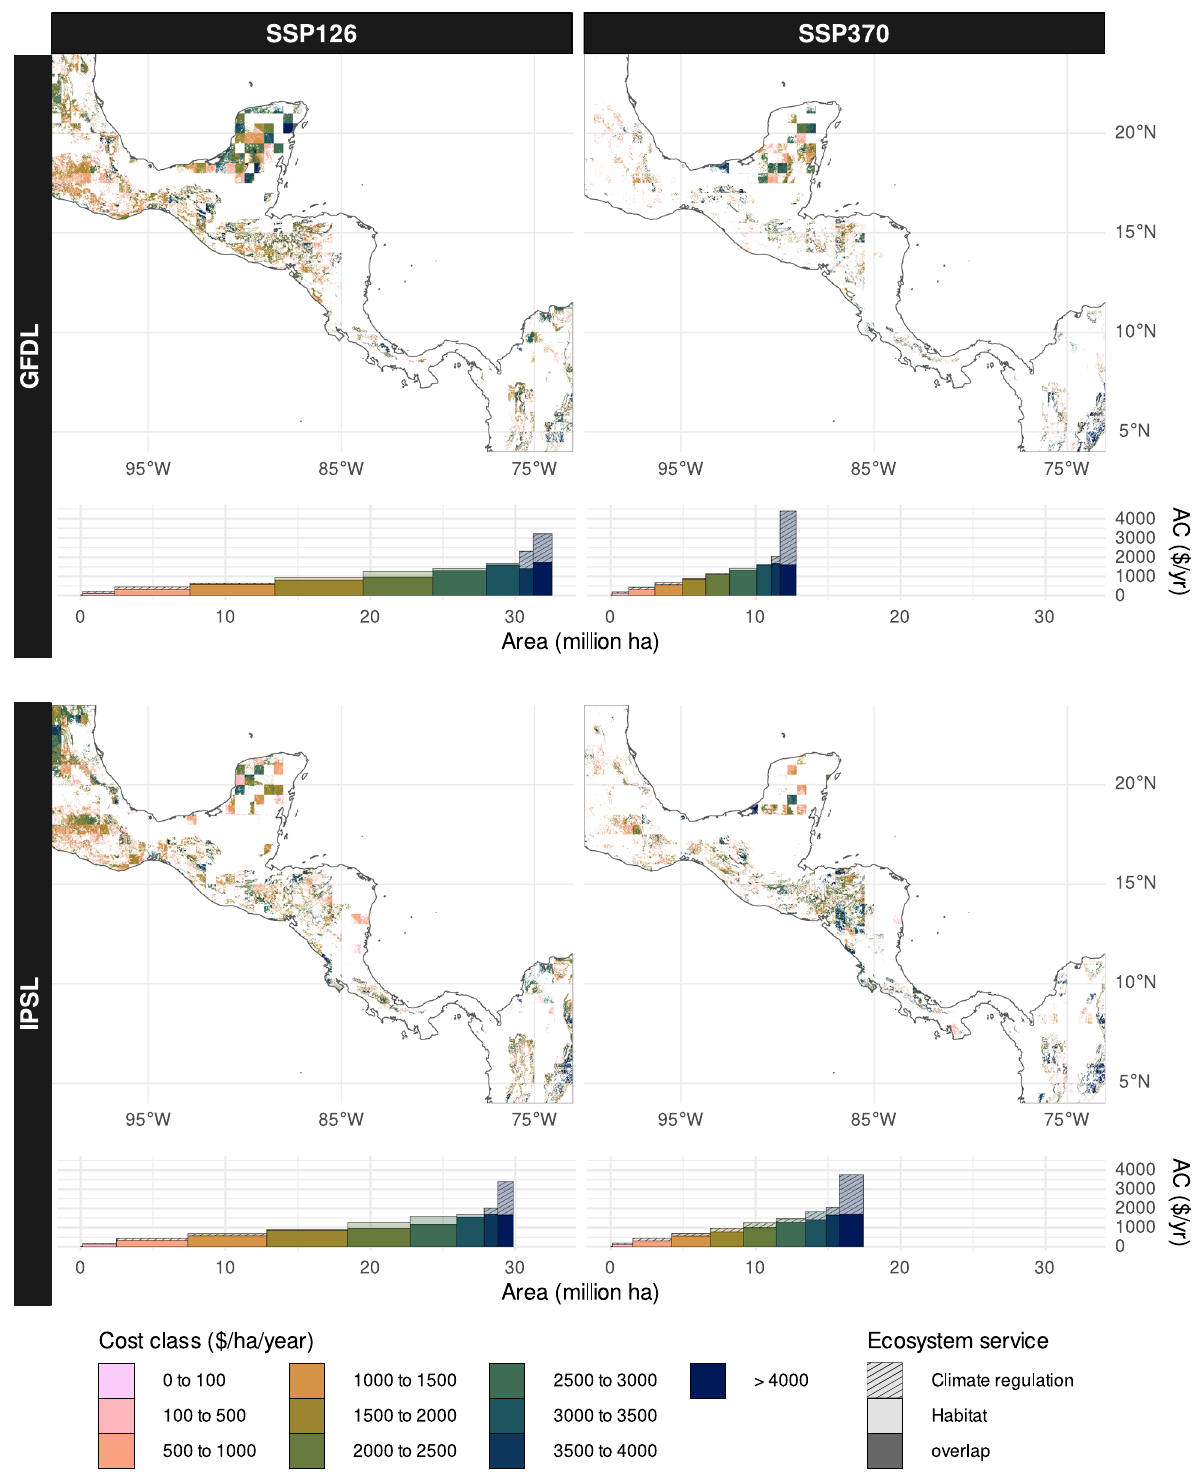
Fig. 4 | Economic hot spots (global prices, no discounting). The here presented maps show projected economic losses in areas where both ES declined for each climatescenario(globalclimatemodels:GFDL=GFDL-ESM4,IPSL=IPSL-CM6A-LR; shared socio-economic pathways: SSP126=SSP1-2.6, SSP370=SSP3-7.0). Cost